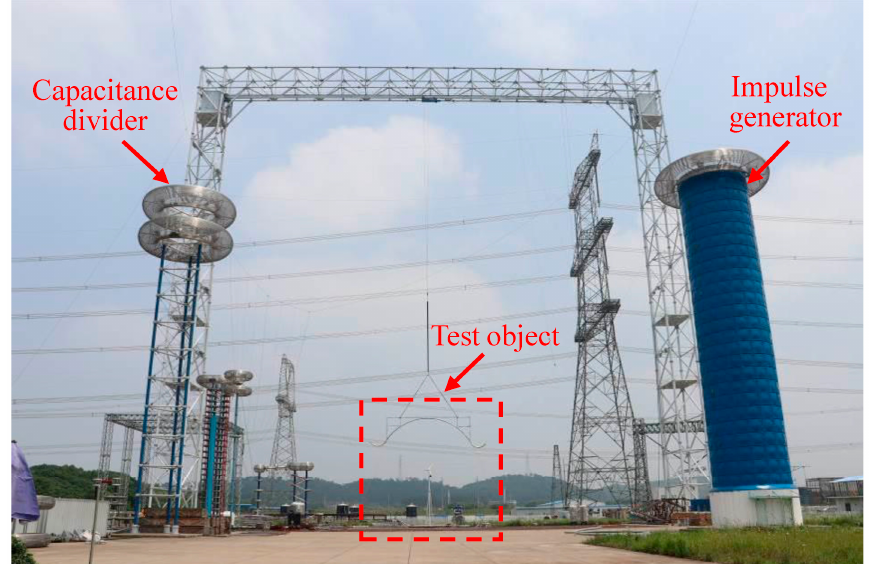
Figure 1. Arrangement of practical test field.